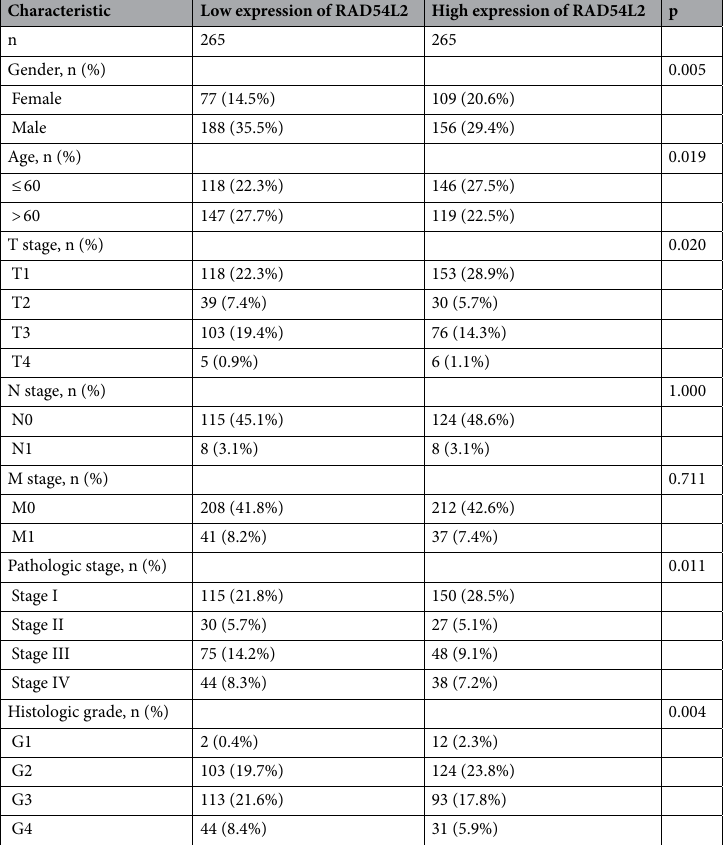
Table 2. Clinicopathological characteristics of RCC patients with differential Rad54l2 expression. RCC renal cell